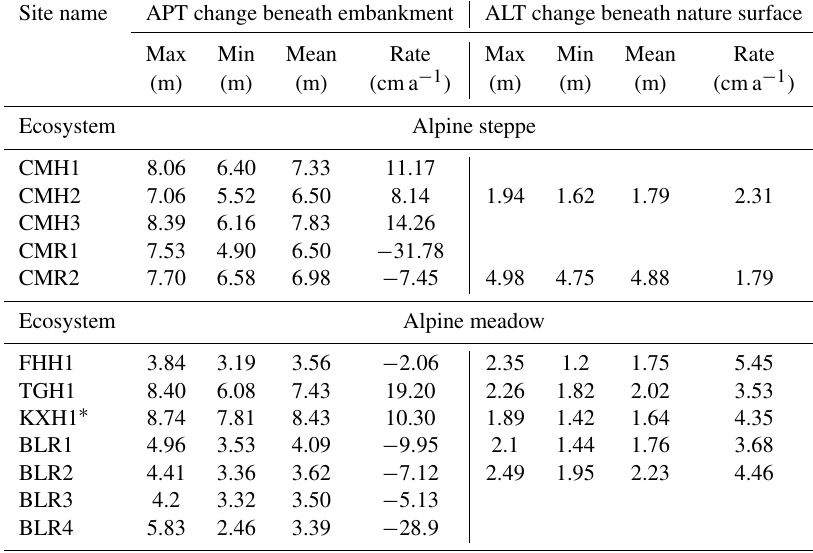
Table 3. Rate of change for artificial permafrost table (APT).